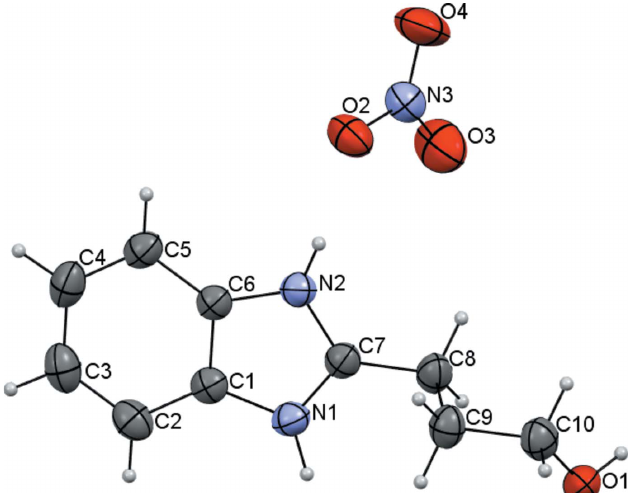
Figure 2 Molecular structure of the 2-(3-hydroxypropyl)benzimidazole nitrate salt in the BIZHNO3 structure. Displacement ellipsoids are shown at the 50% probability level.